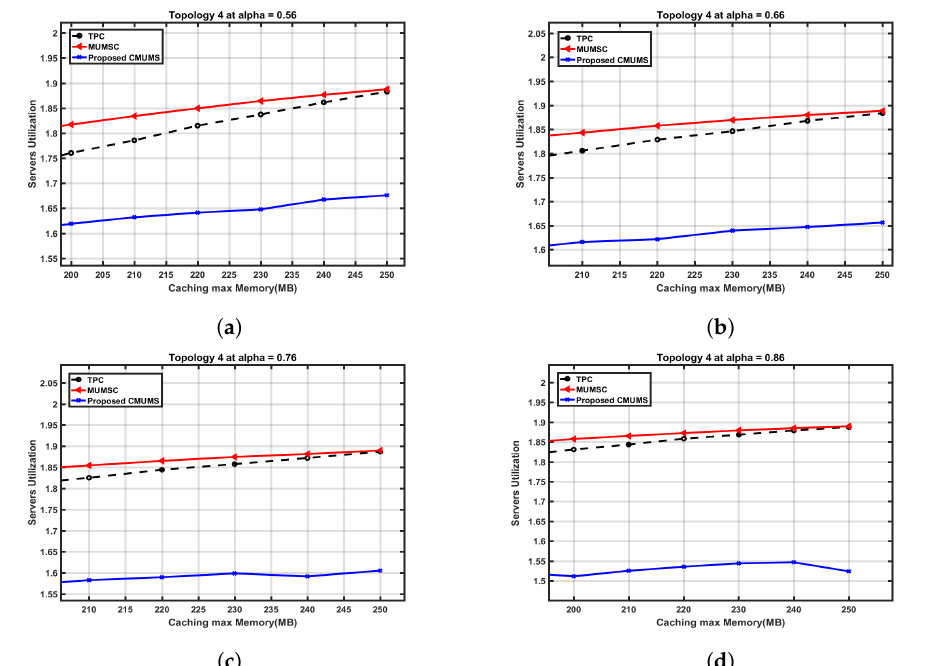
Figure 14. Cross section of server occupancy utilization ratio vs. caching max Memory (Q) up to 250 MB at different α . ( a ) Server utilization ratio vs. Q (at α = 0.56 as per [21]); ( b ) Server utilization ratio vs. Q at α = 0.66; ( c ) Server utilization ratio vs. Q at α = 0.76; ( d ) Server utilization ratio vs. Q at α = 0.86.